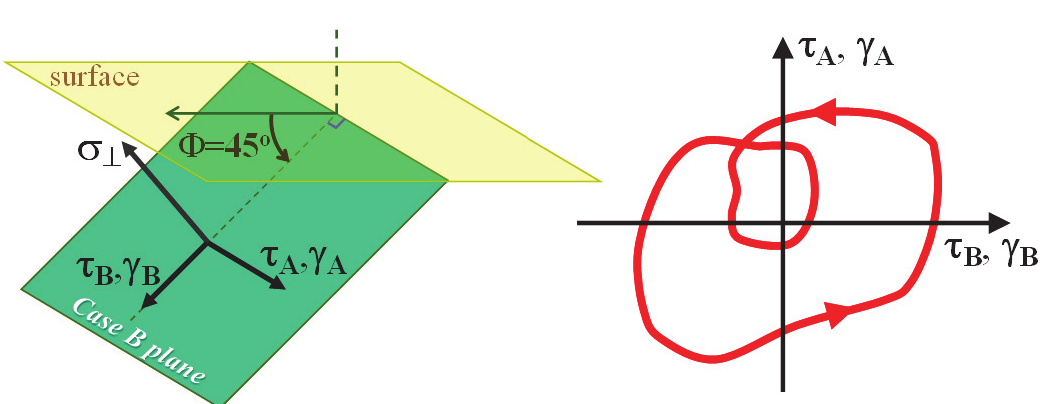
Figure 1: Non-proportional shear strain path  B   A (or shear stress path  B   A ) acting on a B45 candidate plane (at 45 o from the free surface), for a general loading